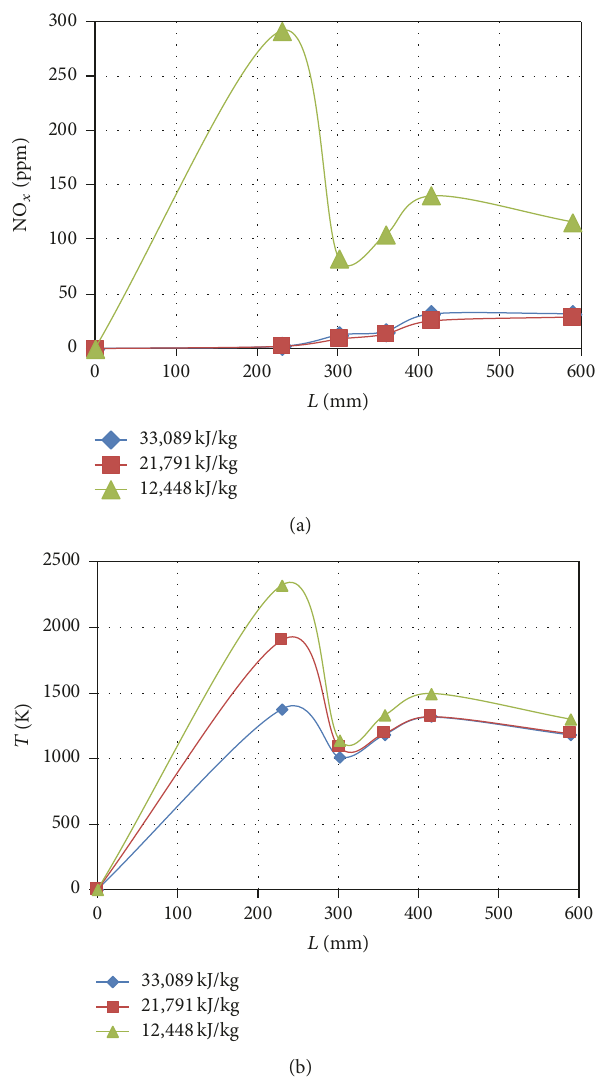
Figure 19: Combustor characteristics: (a) change of the nitrogen oxides emission; (b) change of average temperature along the combustor which operates on various content synthesis